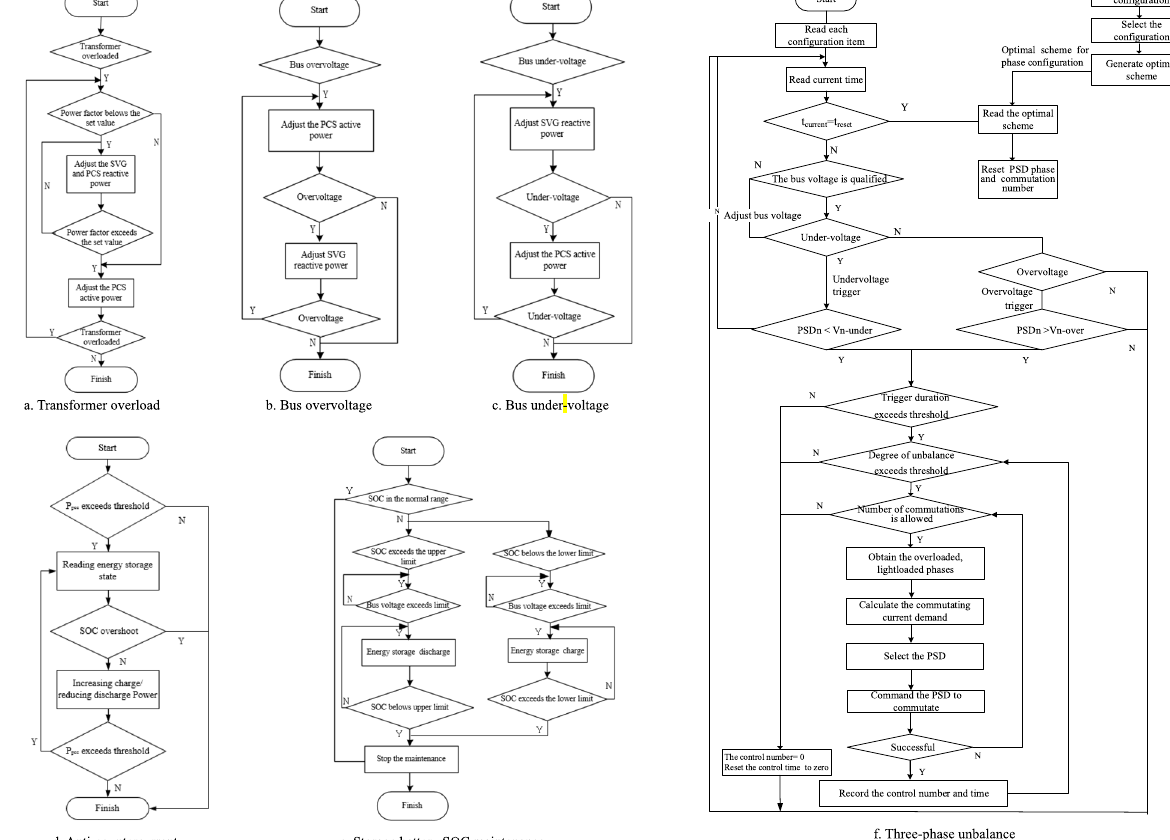
Fig. 5 Control strategy flow charts. a Transformer overload. b Bus overvoltage. c Bus under-voltage. d Anti-countercurrent. e Storage battery SOC maintenance. f Three-phase